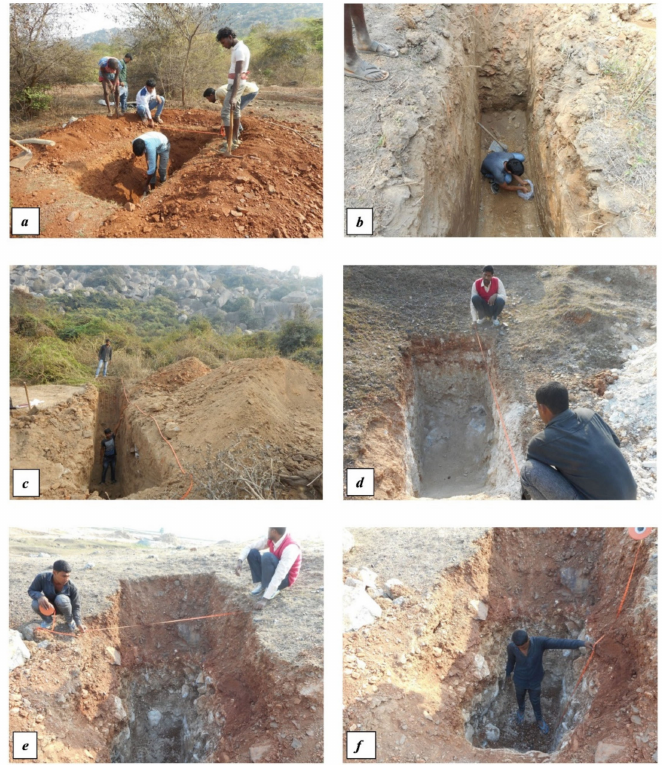
Figure 12. Field photographs showing: ( a ) Trench TRNM-02, NE of Mahadeva Temple; ( b ) Trench TRM-03, SE of Mahadeva Temple; ( c )Trench PTNM-01, NE of Mahadeva Temple; ( d ) Trench PTR-01 North of Ramnath Bigha; ( e , f ) Trench PTR-02, 750 m SW of Patal Ganga.